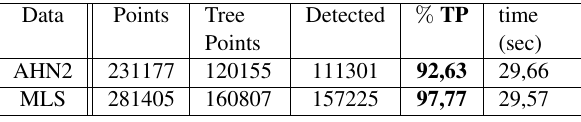
Table 1: Tree classification performances on AHN2 and MLS point clouds of a large area at TUDelft